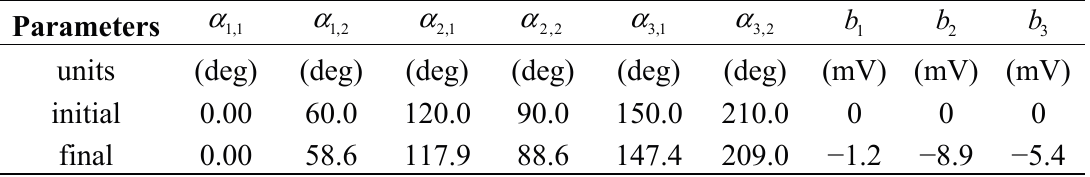
Table 3. Calibration parameter estimation of our real